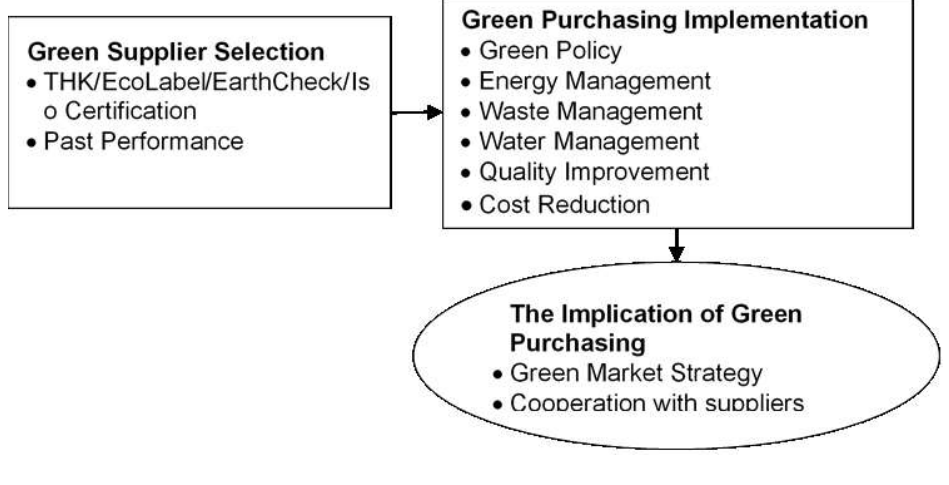
Figure 1. Conceptual